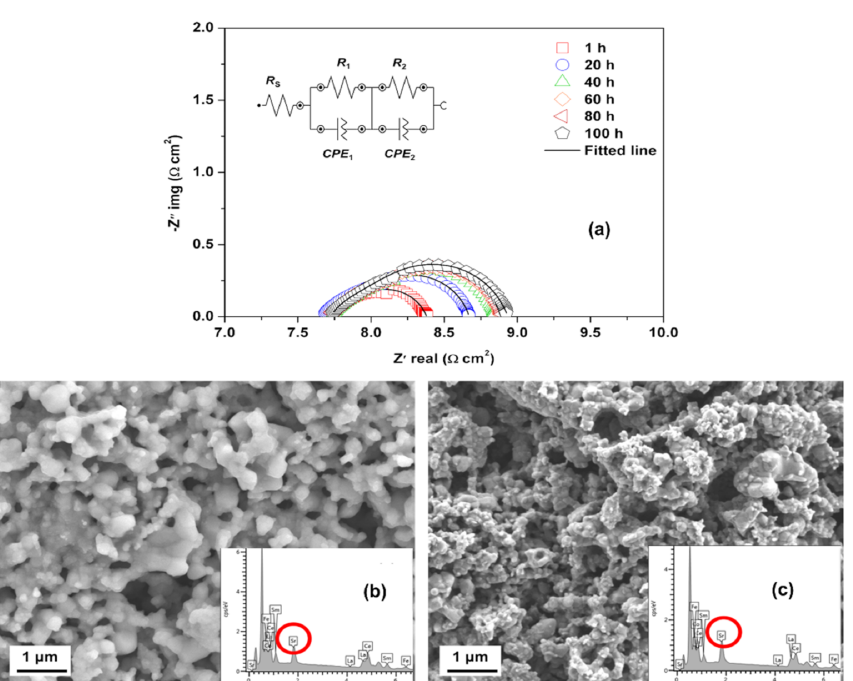
Figure 11. ( a ) EIS spectra as a function of thermal treatment time measured at 600 ◦ C and FESEM surface images and EDX spectra of LSCF cathode ( b ) before and ( c ) after the thermal treatment. (Reprinted with permission from Reference [65], copyright Springer Nature,